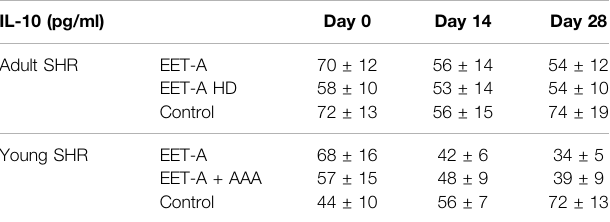
Values are expressed as means ± SEM ( n (cid:1) 6 in each group); not signi fi